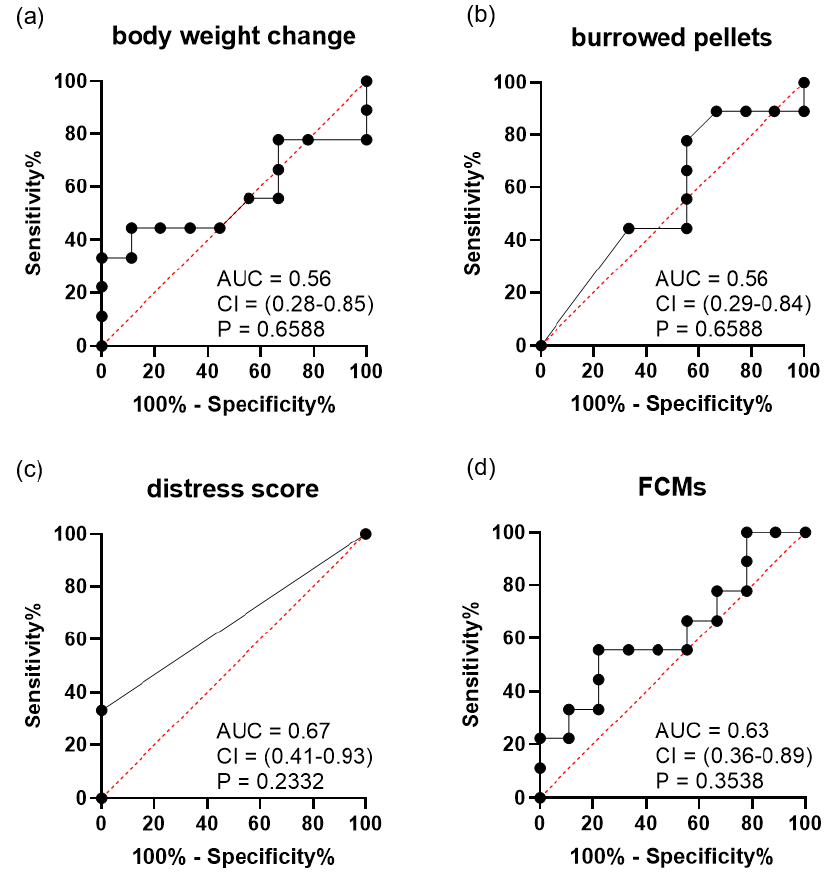
Figure 4. Diagnostic ability of distress parameters when differentiating between the mice before cancer cells were injected and identical mice bearing SCL-2 tumors in the late phase (n = 9). ROC curve analysis of ( a ) percentage of body weight change, ( b ) burrowing activity, ( c ) distress score, ( d ) concentration of faecal corticosterone metabolites (FCMs). The area under the curve (AUC), the 95% confidence interval (CI) and the P-value (P) for testing the AUC to be 0.5 are presented in each graph.